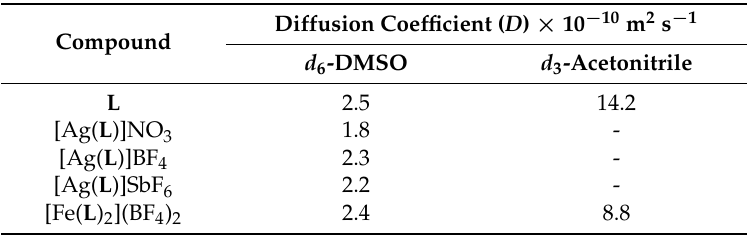
Figure 2. Partial stacked 1 H-NMR spectra (500 MHz, d 6 -DMSO, 298 K) of ( a ) L ; ( b ) [Ag( L )]NO 3 ; ( c ) [Ag( L )]BF 4 ; ( d ) [Ag( L )]SbF 6 and ( e ) [Fe( L ) 2 ](BF 4 ) 2 and (500 MHz, d 3 -acetonitrile, 298 K) ( f ) L and ( g ) [Fe( L ) 2 ](BF 4 ) 2 . Table 1. 1 H DOSY data (500 MHz, 298 K) for the silver(I) and iron(II) complexes.